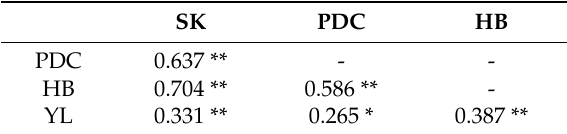
Table 4. Person correlation coefficients between tree ring width residual chronologies of four sites for the common period